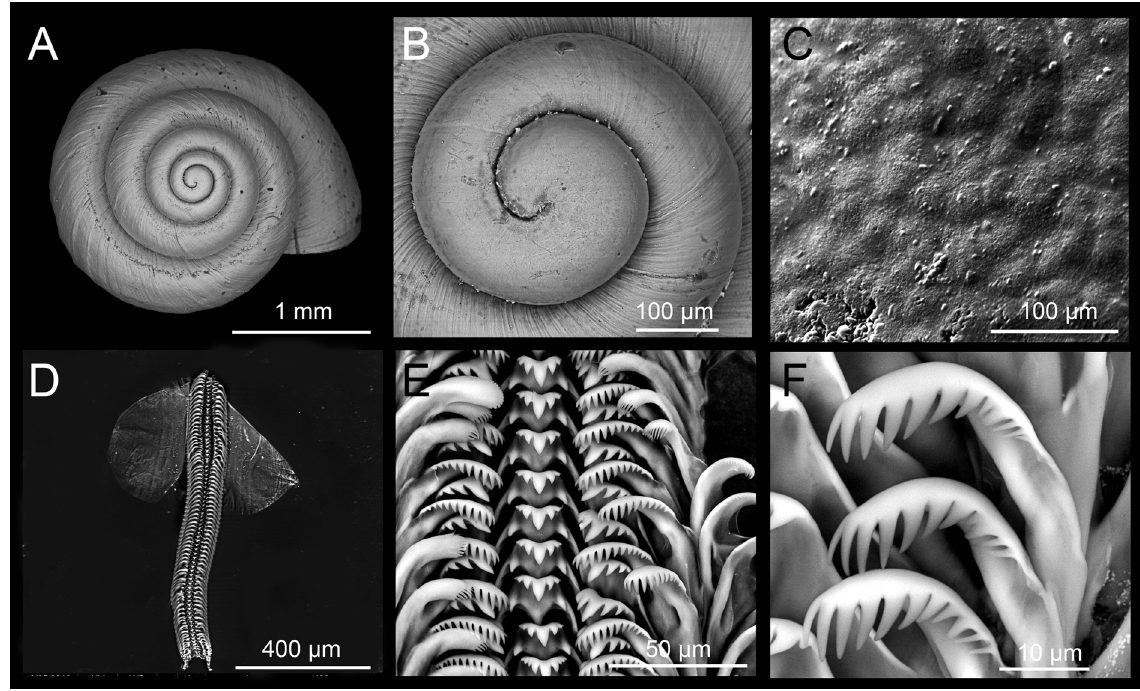
Fig. 5. Shell and radula of Mercuria similis (Draparnaud, 1805) from Étang de Berre, Bouches-du- Rhône, France. A . Apical view of the shell. B . Details of the protoconch. C . Protoconch microsculpture. D . General view of the radular ribbon. E . Central, lateral, inner marginal and outer marginal teeth. F . Detailed view of the inner marginal